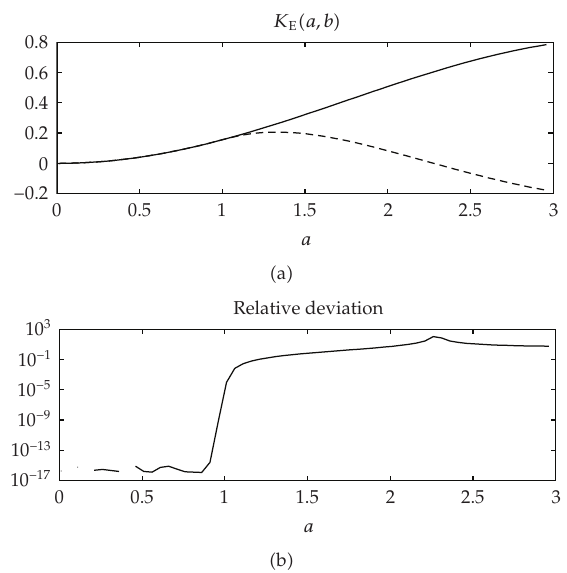
Figure 8: Comparison of the direct series evaluation (cid:2) solid (cid:3) and the analytic representation (cid:2) dashed (cid:3) for the even-order spectra K E (cid:2) a,b (cid:3) with n (cid:6) 1, b (cid:6) 0 . 5 as a is varied. The inset shows the relative di ff erence between the direct series evaluation and the analytic